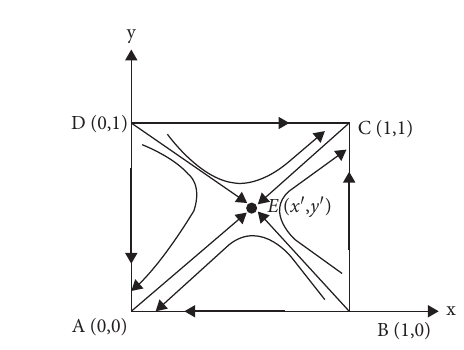
Figure 4: The stable strategy of the evolutionary game system when M > N and M > N . 1 1 2 2 Table 7: Initial values of relevant parameters.